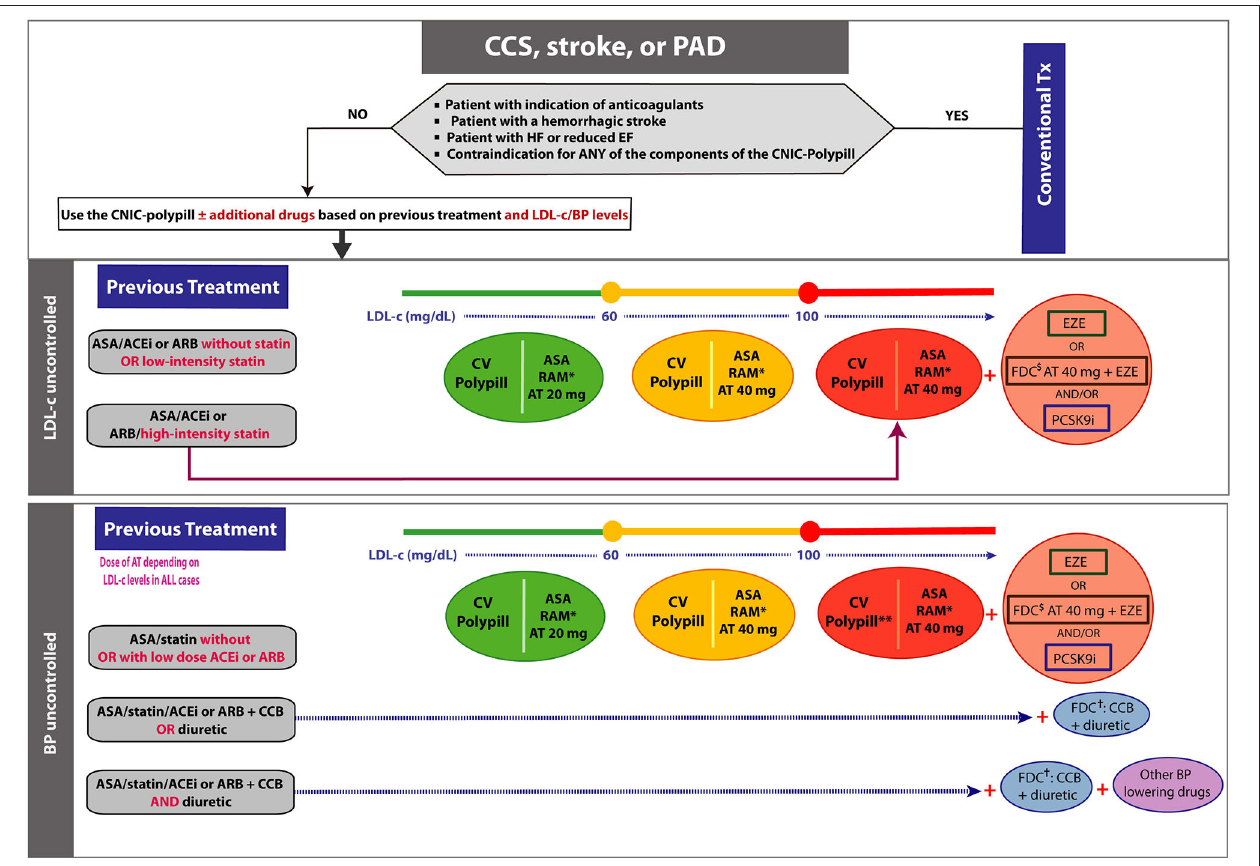
FIGURE 2 | Algorithm showing the steps and options to switch patients treated for chronic coronary syndromes to the CNIC-Polypill strategy. Note: The colored balls represent the appropriate formulation of the CNIC-Polypill according to the colored lines of the algorithm. *Dose adjusted to BP levels, previous ACEI/ARB dose and renal function. **See above for additional treatment of high LDL-c levels. $ Use only if the patient does not develop side effects to atorvastatin 80mg (or equivalent doses of another statin). † If the combination is available. ACEI, angiotensin-converting enzyme inhibitor; ARB, angiotensin II receptor blocker; ASA, acetylsalicylic acid; AT, atorvastatin; BP, blood pressure; CCB, calcium channel blocker; CCS, chronic coronary syndrome; EZE, ezetimibe; FDC, fixed-dose combination; LDL-c, low-density lipoprotein cholesterol; PAD, peripheral artery disease; PCSK9i, proprotein convertase subtilisin/kexin type 9 inhibitor; RAM, ramipril; Tx, treatment.